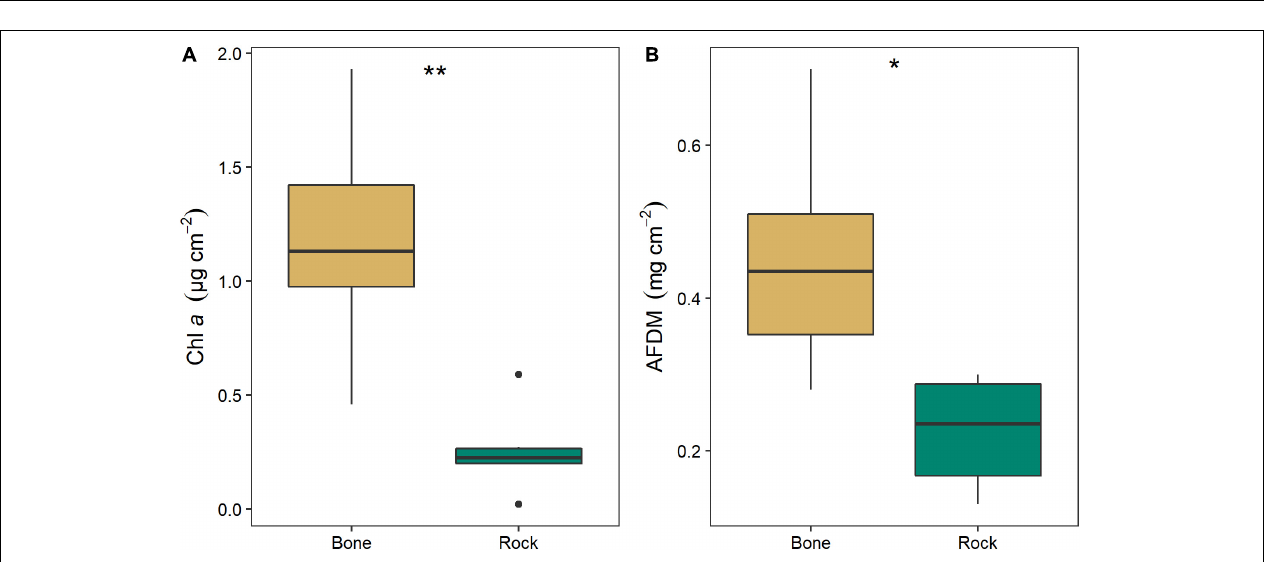
FIGURE 7 | (A) Water column chl a and (B) biofilm ash free dry mass (AFDM) on ceramic tiles in experimental streams with all gravel benthos (control treatment; n = 4) or half gravel-half bone benthos (bone treatment; n = 2) in Week 1, after equilibration and just before treatments were applied, and in Weeks 2 and 3 of the experiment, after treatments were applied.